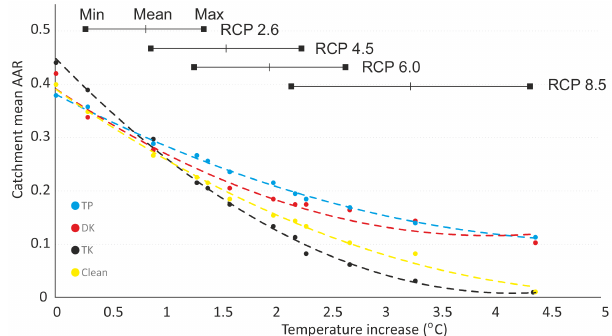
Figure 7. Projected AARs (averaged across each catchment) based on different scenarios of temperature increase relative to the present day and accompanying ELA rise. Temperature rise scenarios have been used from the IPCC AR5 Working Group report. P is Pumqu, DK is Dudh Koshi, TK is Tama Koshi and Clean is clean-ice glaciers. Each point represents a projected AAR given minimum, mean or maximum temperature rise under each RCP